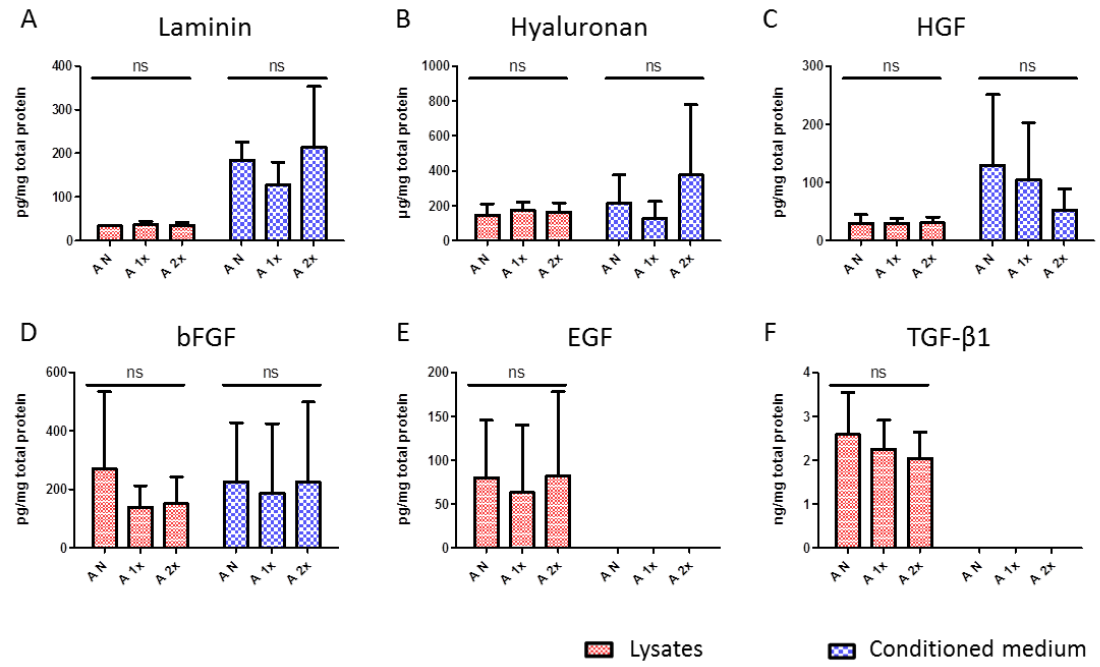
Figure 1. Content of growth factors and extracellular matrix proteins in lysates and the conditioned medium from non-frozen (A N), one-time frozen (A 1 × ), and two times frozen (A 2 × ) human amniotic membrane (hAM). Histograms show results of ELISA analysis for the presence and quantity of ( A )—laminin; ( B )—hyaluronic acid; ( C )—hepatocyte growth factor (HGF); ( D )—basic fibroblast growth factor (bFGF); ( E )—epidermal growth factor (EGF); and ( F )—transforming growth factor beta 1 (TGF- β1) in hAM lysates directly after lysis, as well as in the conditioned medium incubated with hAMs for 24 hours. Results are displayed as relative to the total protein amount in each sample ( n = 5). The data are presented as mean ± SD; ns—non-significant difference ( p > 0.05).